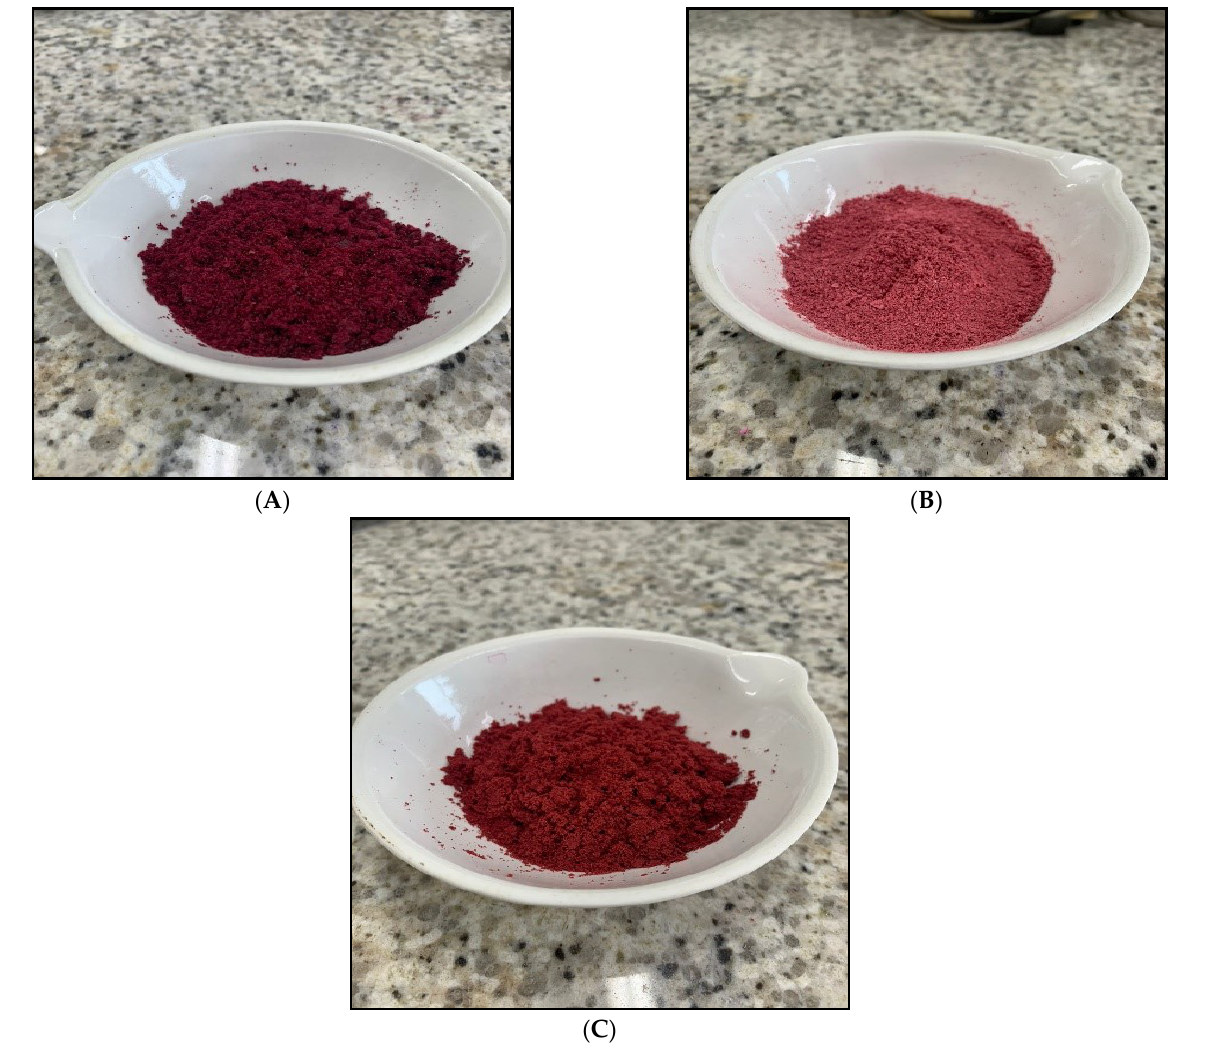
Figure 3. Lyophilized beetroot soup containing no microencapsulating agent ( A ) in starch ( B ) and in maltodextrin ( C ) microencapsulating agents at a 1:2 ratio ( w / w ). Table 4. Betalain, betacyanin and betaxanthin contents and encapsulation efficiencies